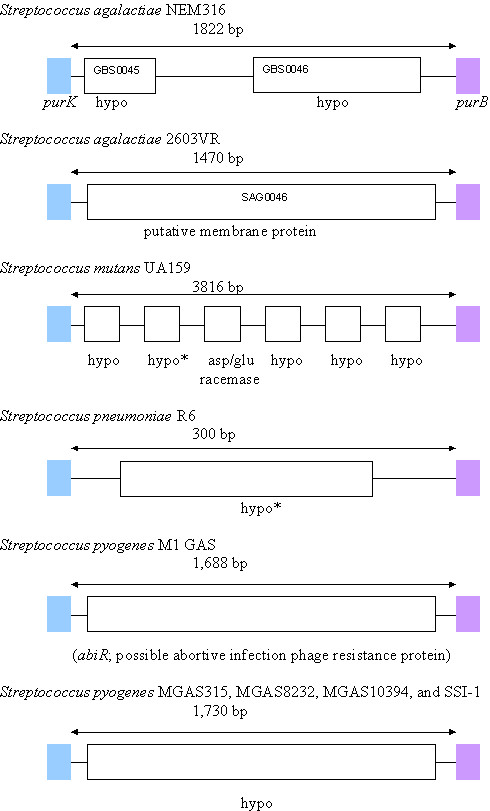
An example of an MME in GBS. Different intergenic regions are depicted between purK (pale blue block) and purB (lavender block) in various streptococcal species. Homologs of gbs0045 are indicated with an asterix. Hypothetical proteins are designated 'hypo'.